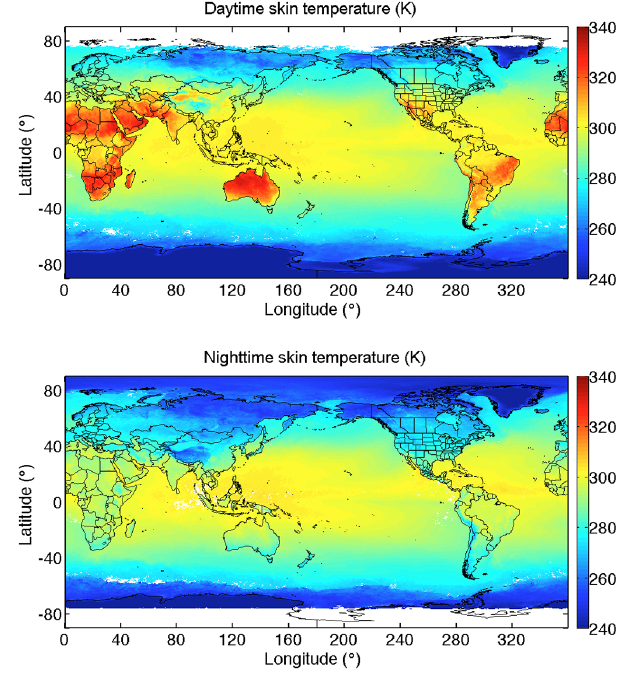
Figure 2. Average surface skin temperature from NOAA-19 AVHRR, October